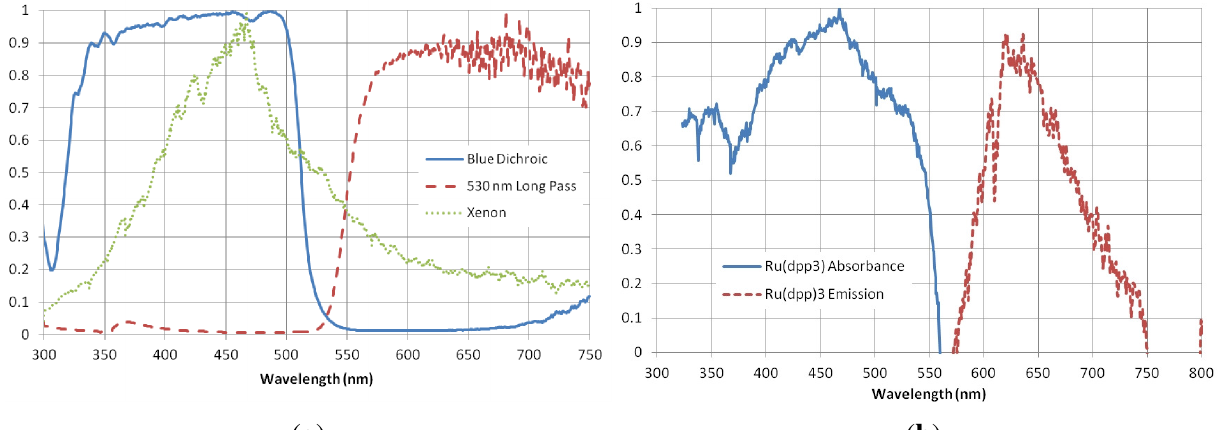
Figure 6. Spectral measurements of filter combination and PSP sample. ( a ) Filters and light source spectra; ( b ) Ru(dpp) 2+ absorption and emission 3